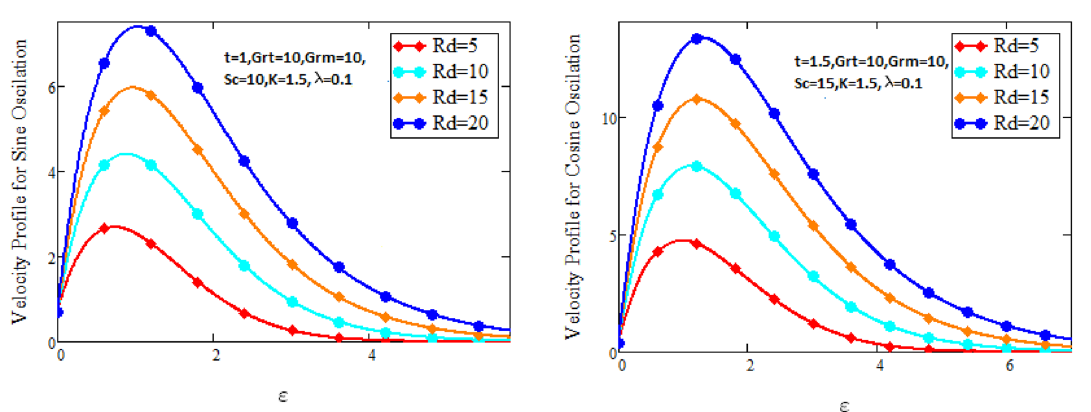
Figure 5. Velocity curves for various values of Rd